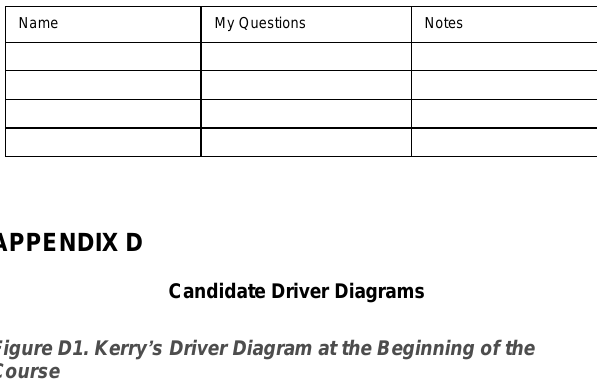
Figure D1. Kerry’s Driver Diagram at the Beginning of the Course